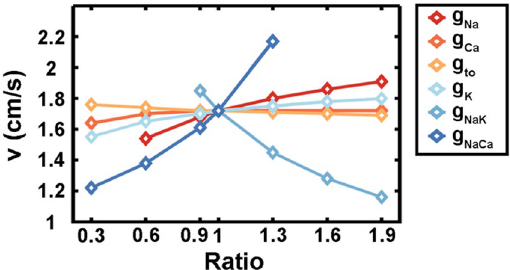
Figure 7. Different ionic current strengths lead to different speeds of one traveling wave in the 3-mm diameter ring. The standard ratio is 1 and the parameters are described in the mathematical model section. If the ratio is less than 1, the corresponding ionic current decreases, while if the ratio is greater than 1, the corresponding ionic current increases